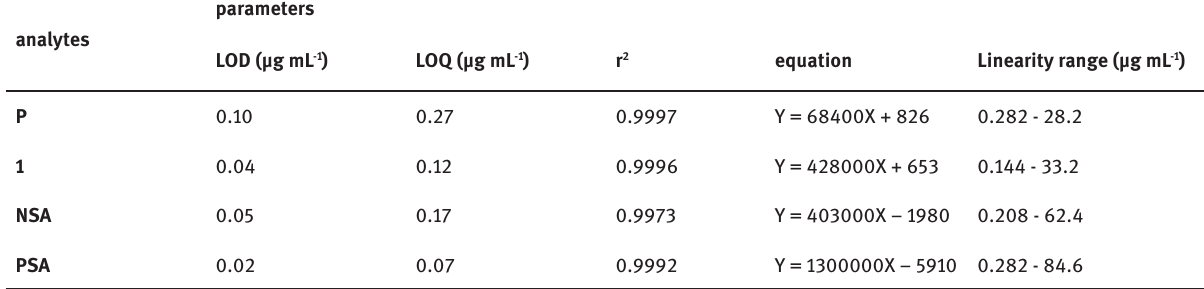
Table 1: Analytical parameters of four analytes.